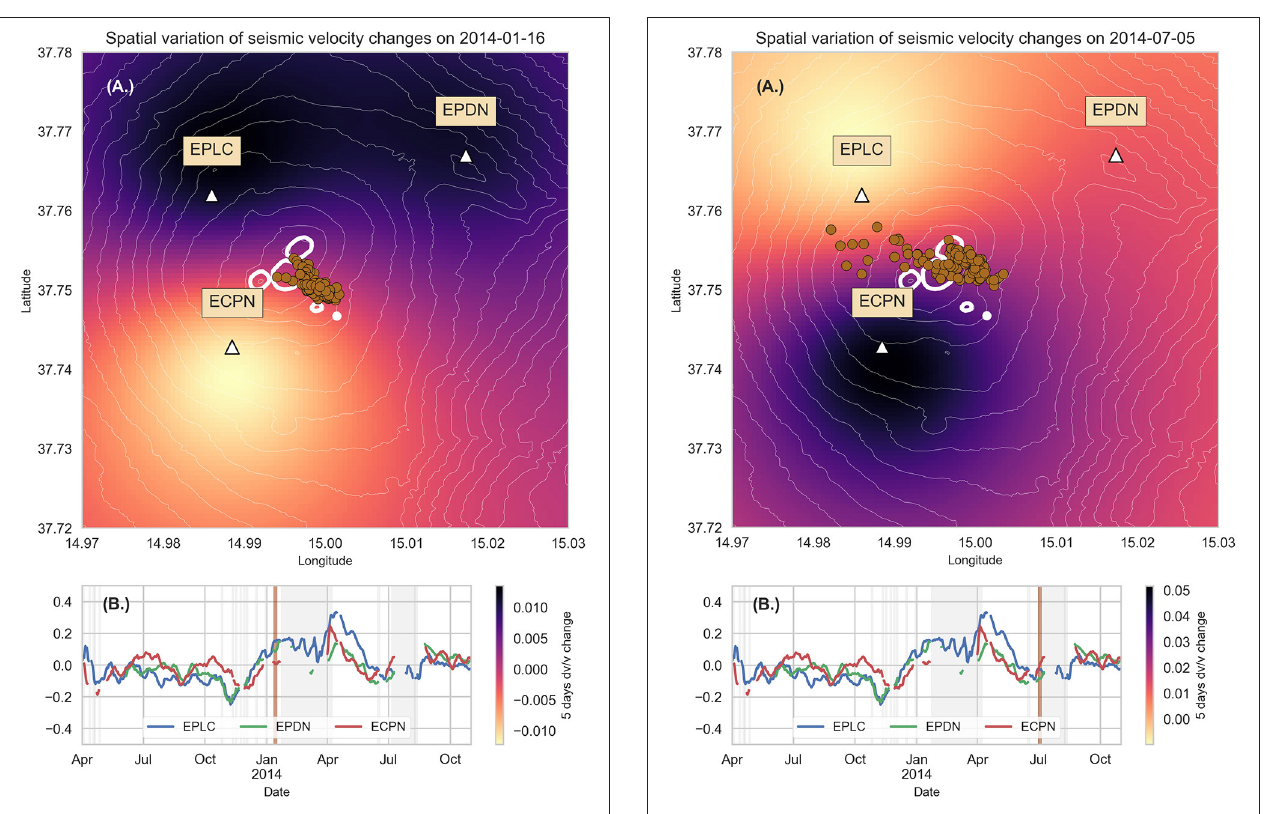
FIGURE 7 | (A) Interpolation map of the variation of seismic velocity over 5 days until 16/01/2014. The brown points are tremor centroid locations for the same time span. The map emphasizes the larger decrease in seismic velocity at station ECPN, the closest to the NSEC which erupted on 21 January. The tremor centroids are clustered near the NSEC. (B) Seismic velocity variation in % at the considered stations centered on the E46 event.